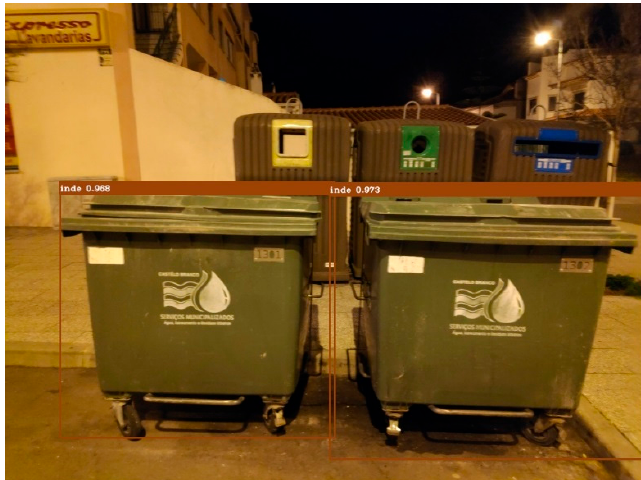
Figure 9. Incorrect detection with occlusion during night.